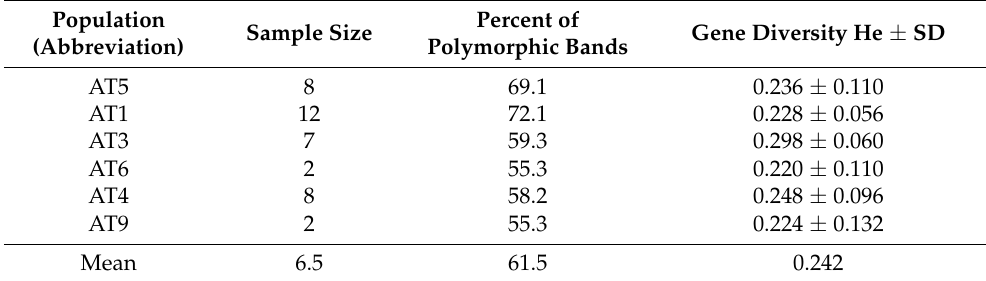
Table 3. Natural populations included in the genetic studies and polymorphism and